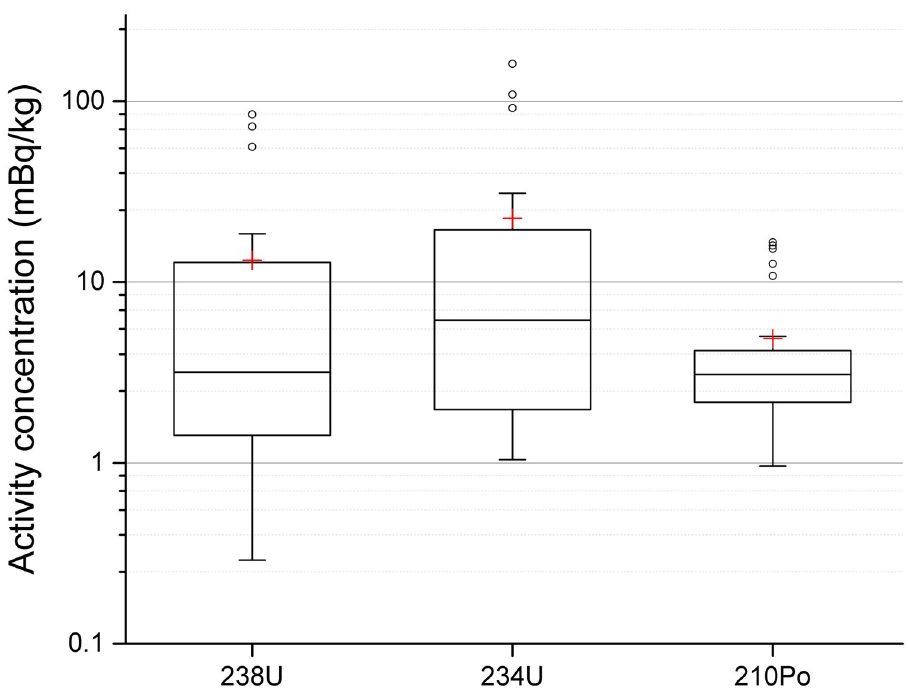
Fig 4. 238 U, 234 U and 210 Po activity concentration in surface water from 27 pit lakes. Results were obtained by alpha spectrometry. The height of the box shows the interquartile range, which contains 50% of the values, the horizontal line inside the box shows the median value and the red cross denotes the mean value. The whiskers are lines that extend from the box to the highest and lowest values excluding outliers (o). Outliers represent those data with values being 1.5 higher or lower than the height of the box. Detailed data are given in supplementary data